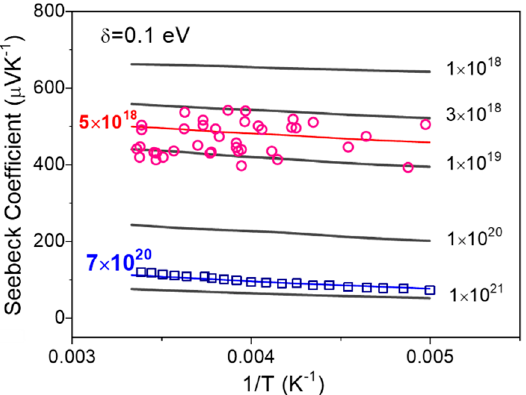
Figure 3. Temperature dependence of Seebeck coefficient at Gaussian width δ = 0.1 eV; experiment data for fitting are from pentacene based FET (red circles), and polymer film based on polyacetylene (blue square).